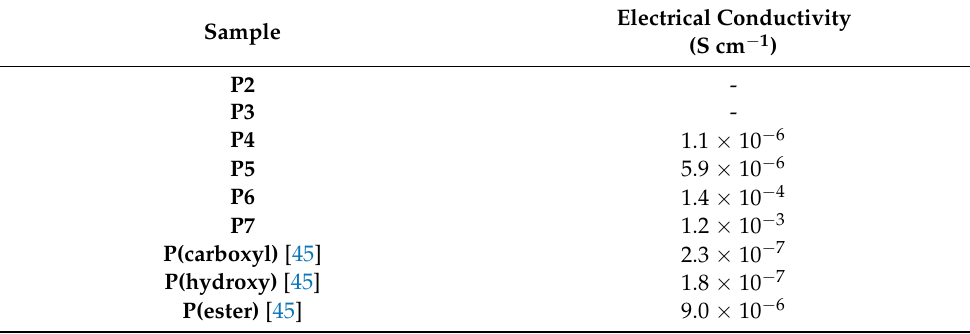
Table 2. Comparison of electrical conductivities of the polymer samples.